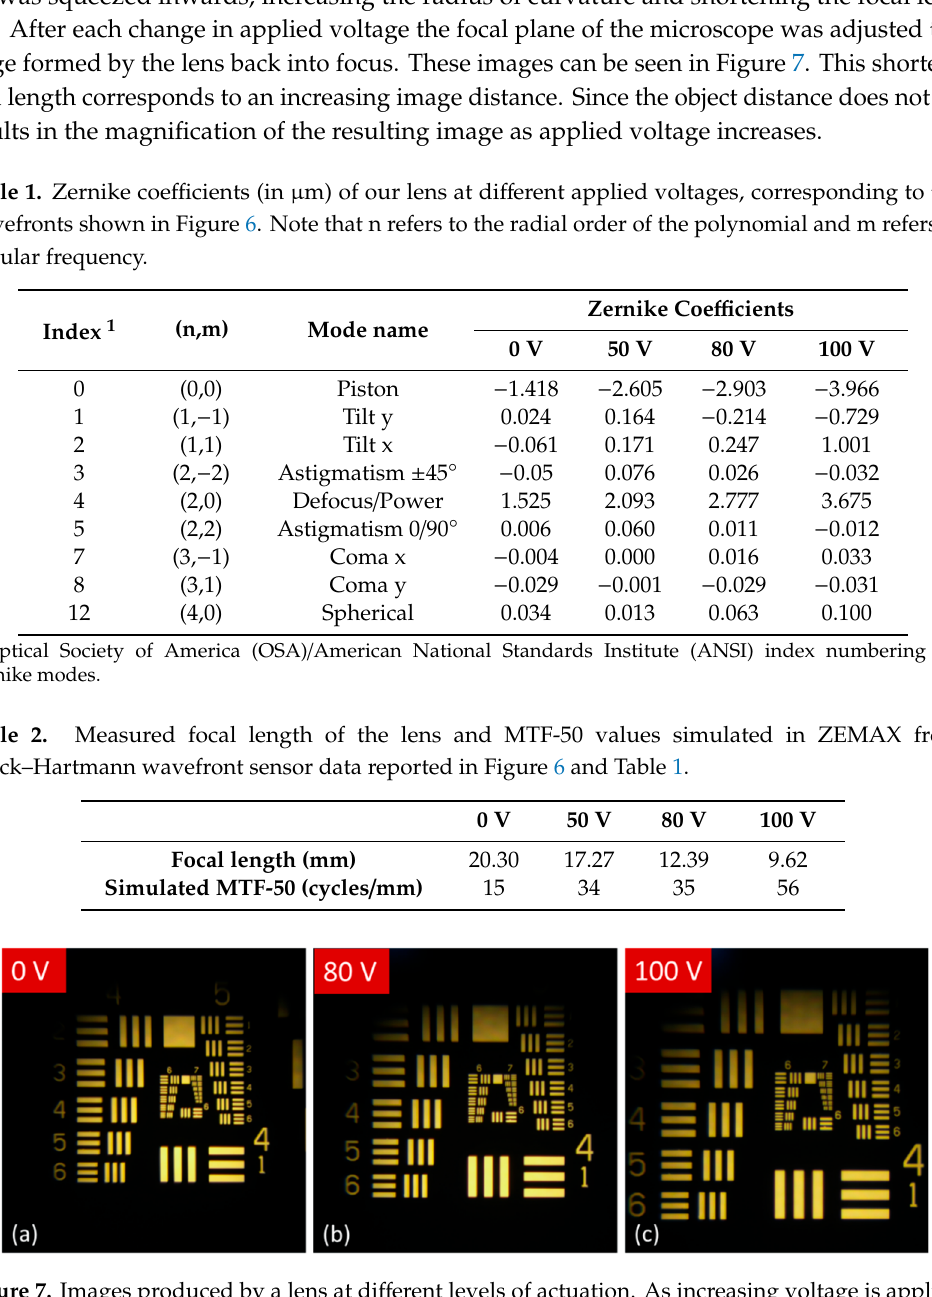
Figure 7. Images produced by a lens at different levels of actuation. As increasing voltage is applied the radius of curvature of the liquid lens decreases. Since the object distance remains fixed, the image produced is magnified with decreasing focal length, as expected. ( a ) Microscope image produced by focusing the microscope to the image plane produced by the convex lens at its initial rest state of 0 V applied. ( b ) 80 V is applied to the lens and the microscope focus is readjusted to match the new image plane of the lens, resulting in a larger image of the object. ( c ) When 100 V is applied to drive the lens, the microscope focus is again readjusted to produce a still-larger image.